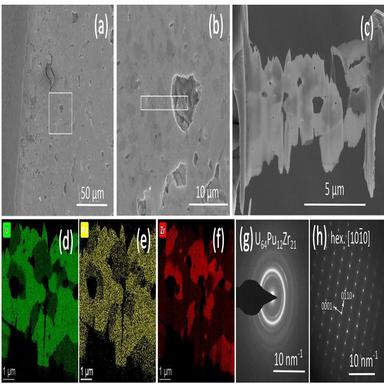
Radial zone 5 is very close to the cladding (a). The precipitates grow to several μm in this region (b), The precipitates are rich in Zr compared with the matrix (c-f). However, the crystal structure analysis based on SAED pattern (g-h) shows the fuel matrix seemingly amorphous and precipitate is in hexagonal structure, isostructural to δ-(U, Pu)Zr2.